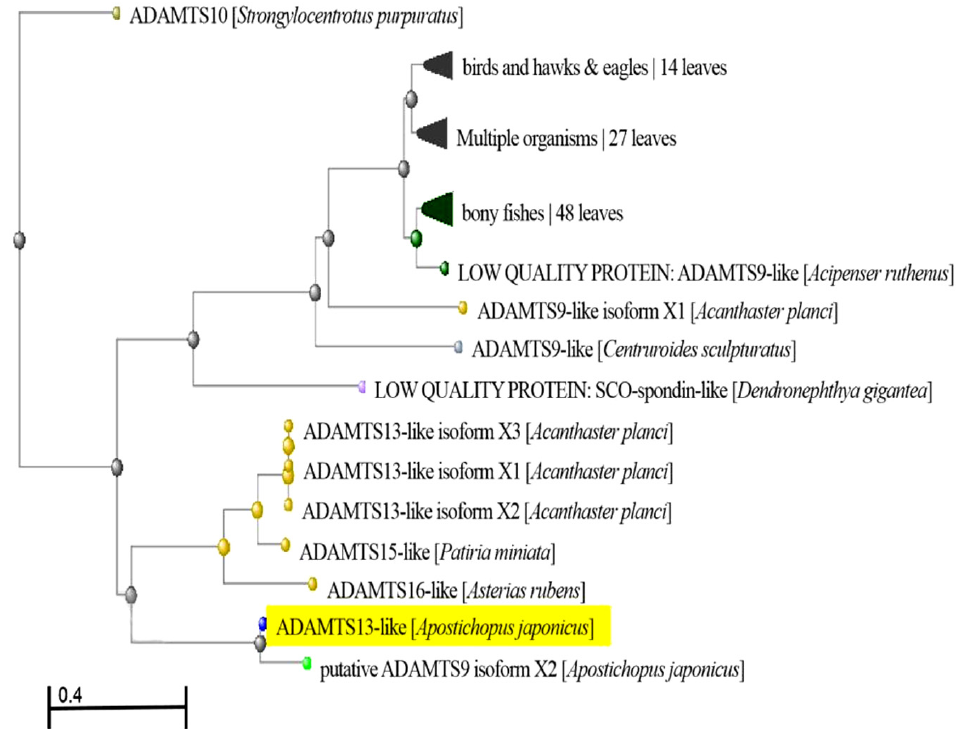
Figure 1. Phylogenetic tree analysis of ADAMTS13-like from A. japonicus .